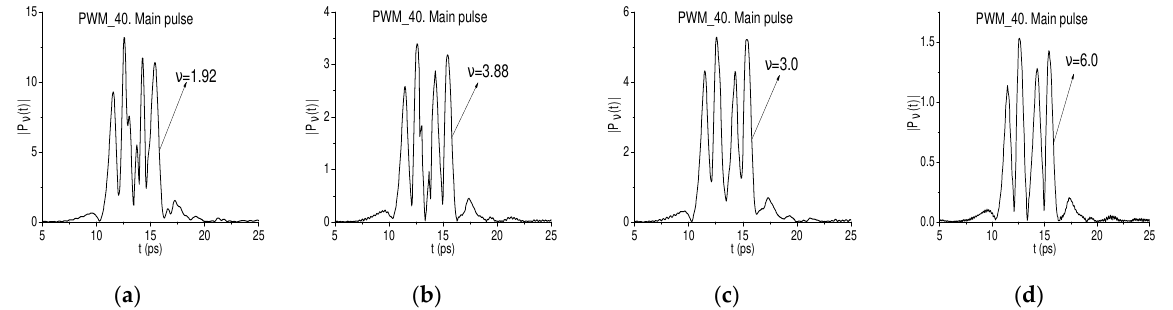
6.0 THz Figure 11c,d.